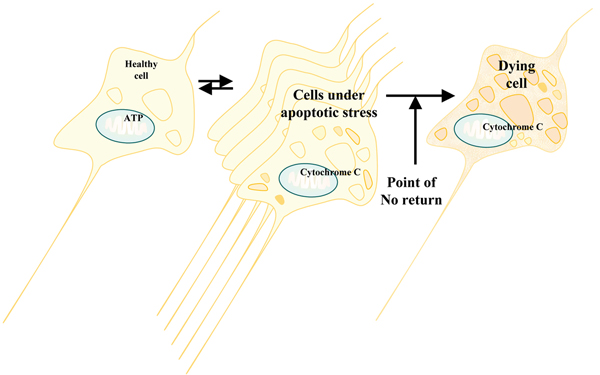
A drawing exemplifying the active "stand-by" status of cells exposed to the various stressful events involved in AD apoptosis. Neuronal death occurs when the cell(s) reaches a point of "No-return", where an overwhelming mitochondria pressure is no longer compensated by the many protective pathways that the cell(s) has adopted.